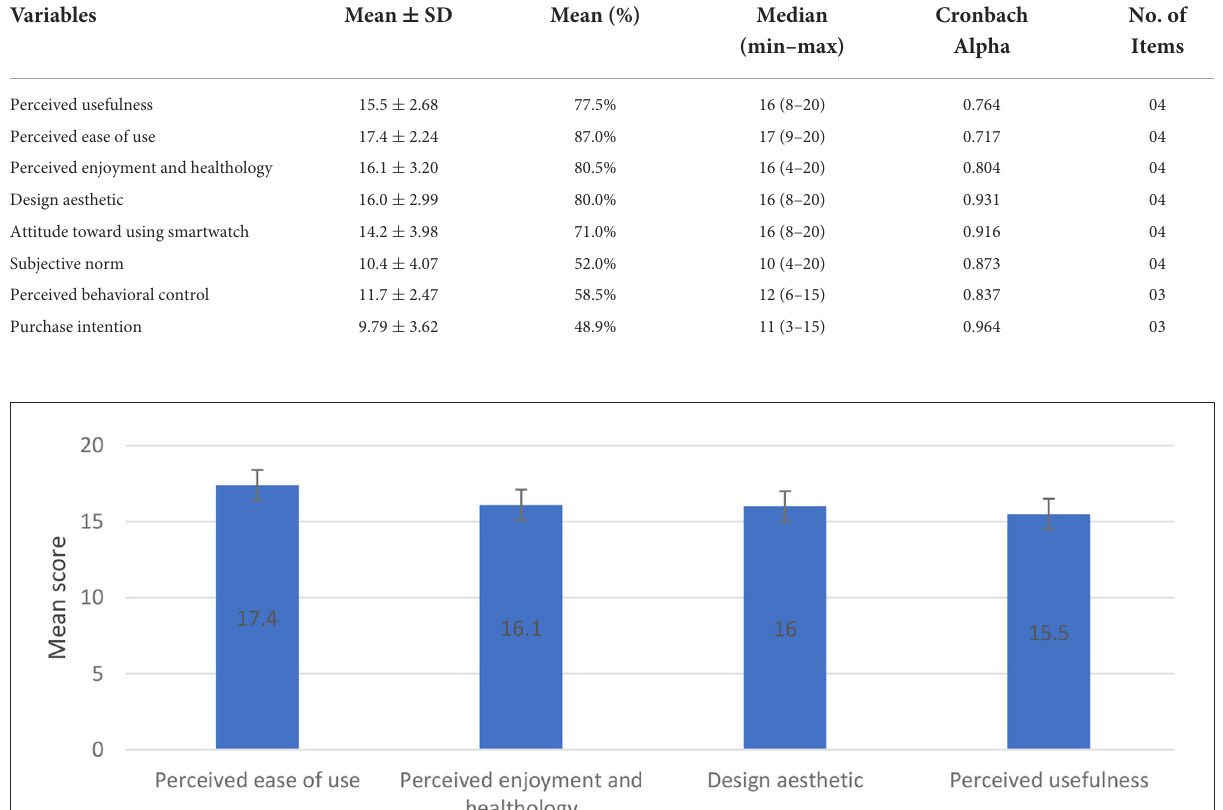
TABLE 2 Descriptive statistics of Technology Acceptance Model (TAM) subscales.